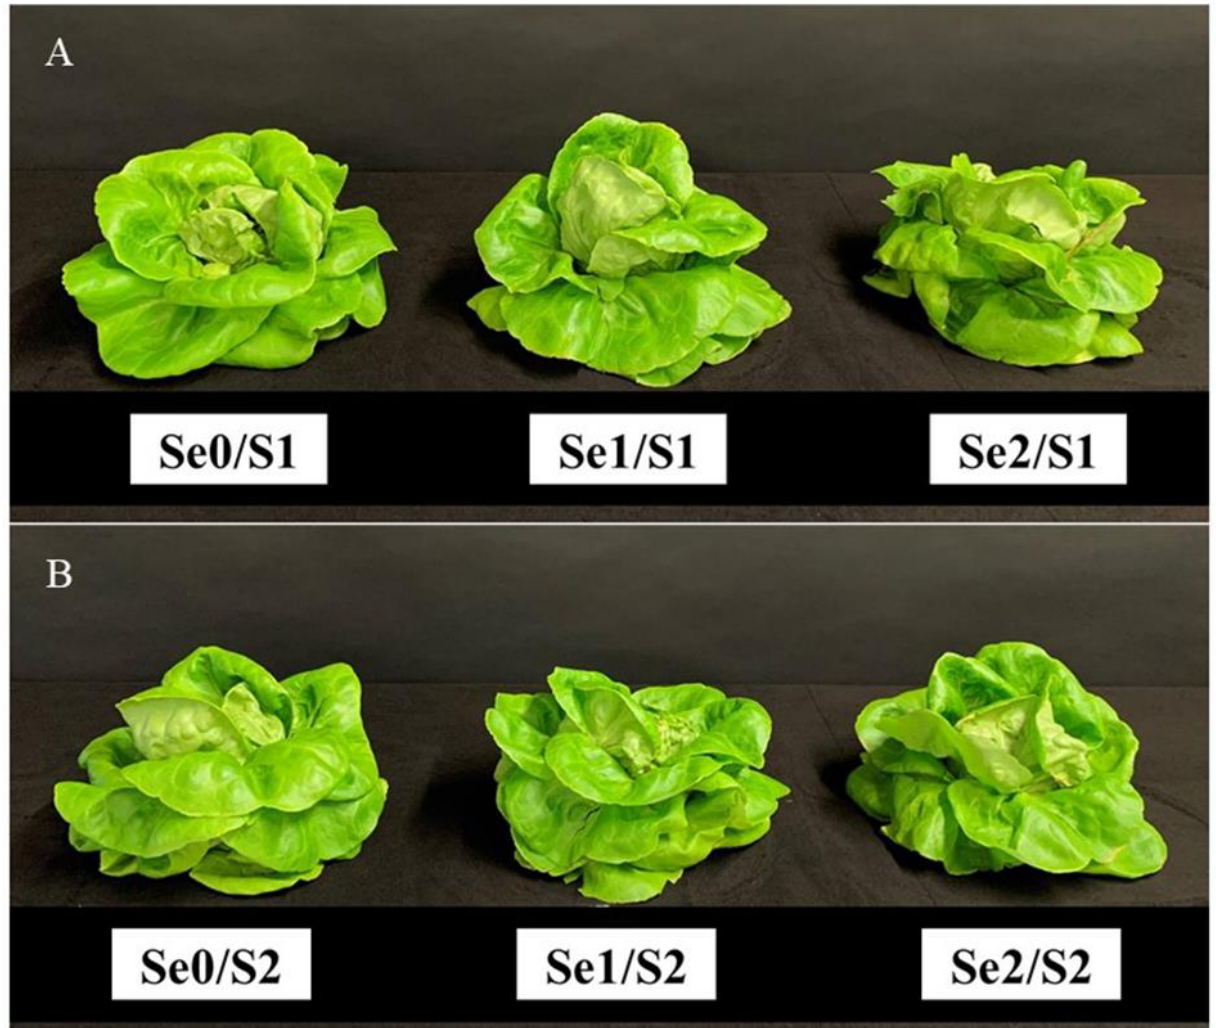
Figure 1. Comparison of the lettuce heads (cultivar: Pazmanea RZ) from a hydroponic system treated with two S levels (S1: 1 mM; and S2: 2 mM (K 2 SO 4 )) and three Se levels (Se0: 0 µM; Se1: 1.3 µM; and Se2: 3.8 µM (Na 2 SeO 4 )). ( A ) Side view of the lettuce heads treated with the S1 level. ( B ) Side view